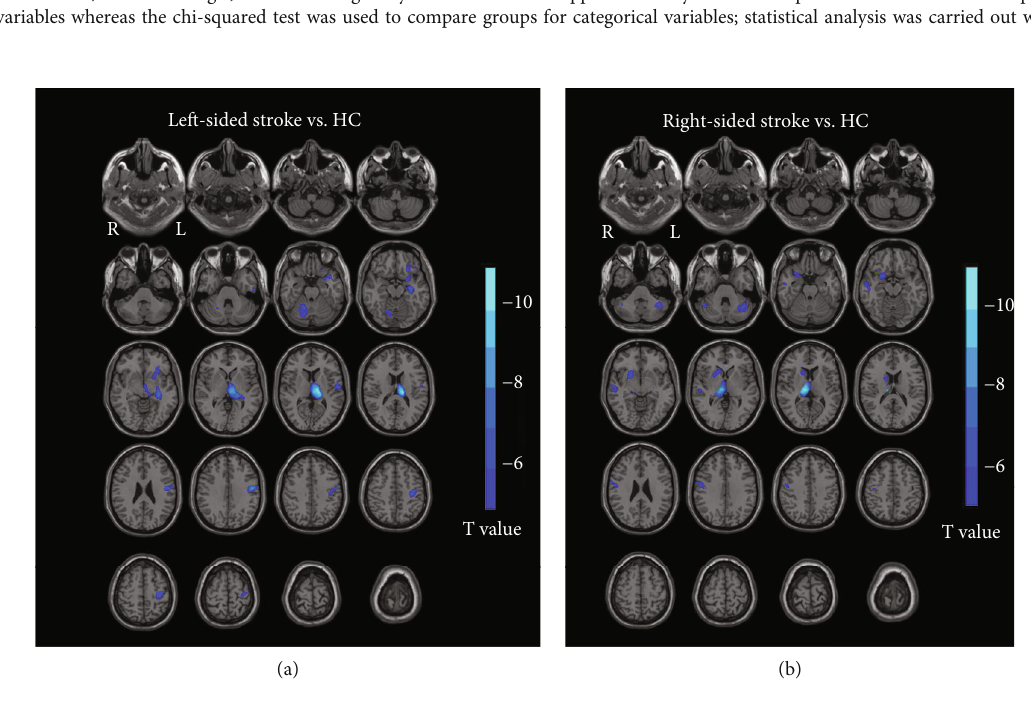
Figure 2: GM volume alterations in stroke patients. (a) Group comparison between left-sided stroke patients and healthy controls ( p < 0 : 05 , FWE corrected). (b) Group comparison between right-sided stroke patients and healthy controls ( p < 0 : 05 , FWE corrected). Abbreviations: L =left hemisphere; R =right hemisphere; HC=healthy controls.